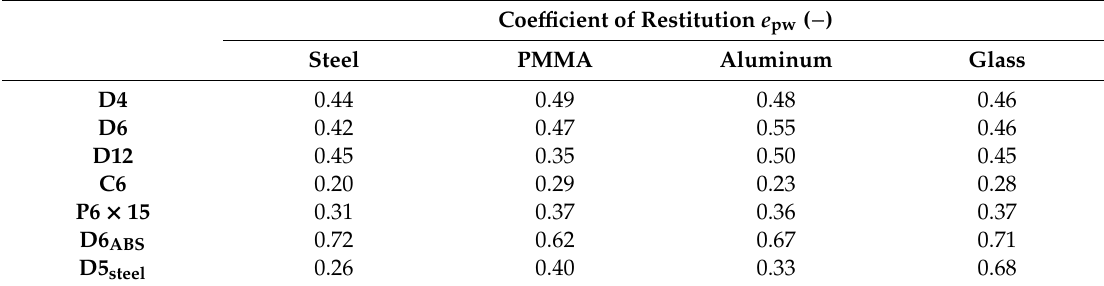
Table A4. Calibrated coe ffi cients of restitution values (CoR